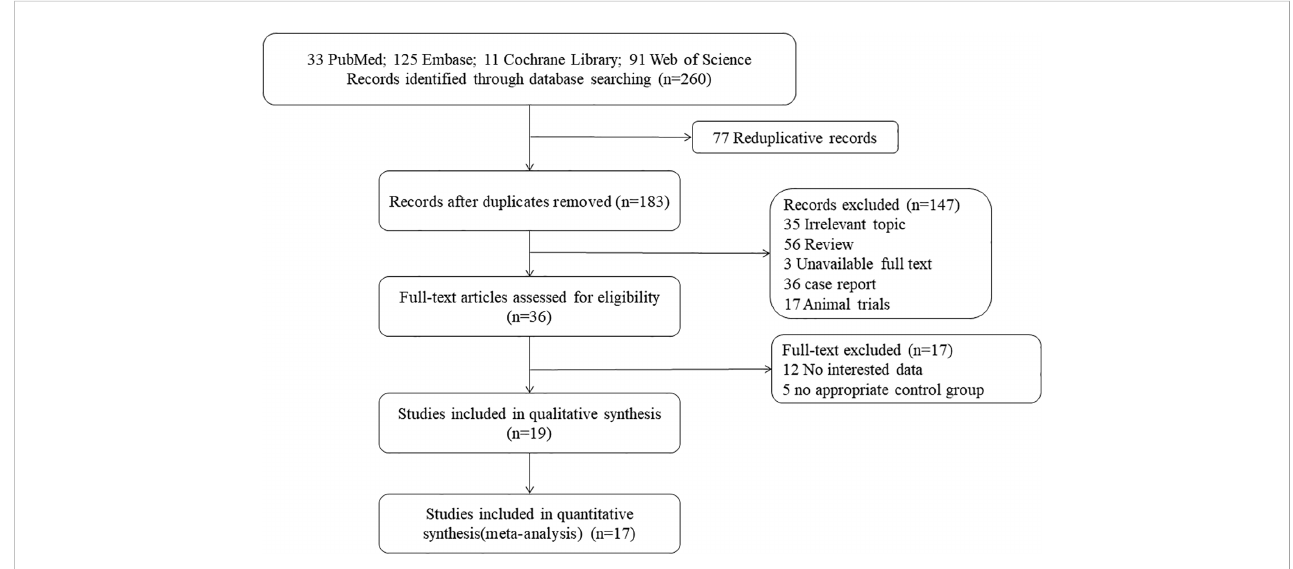
FIGURE 1 The procedures involved in study